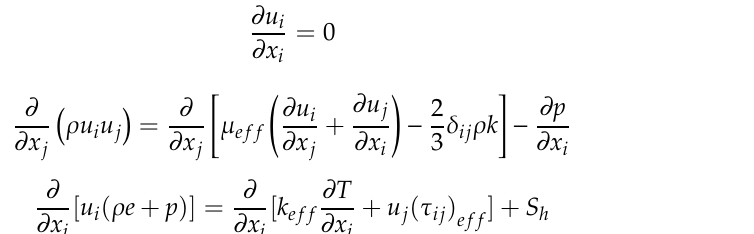
Figure 3. Numerical model of air-cooled unit.